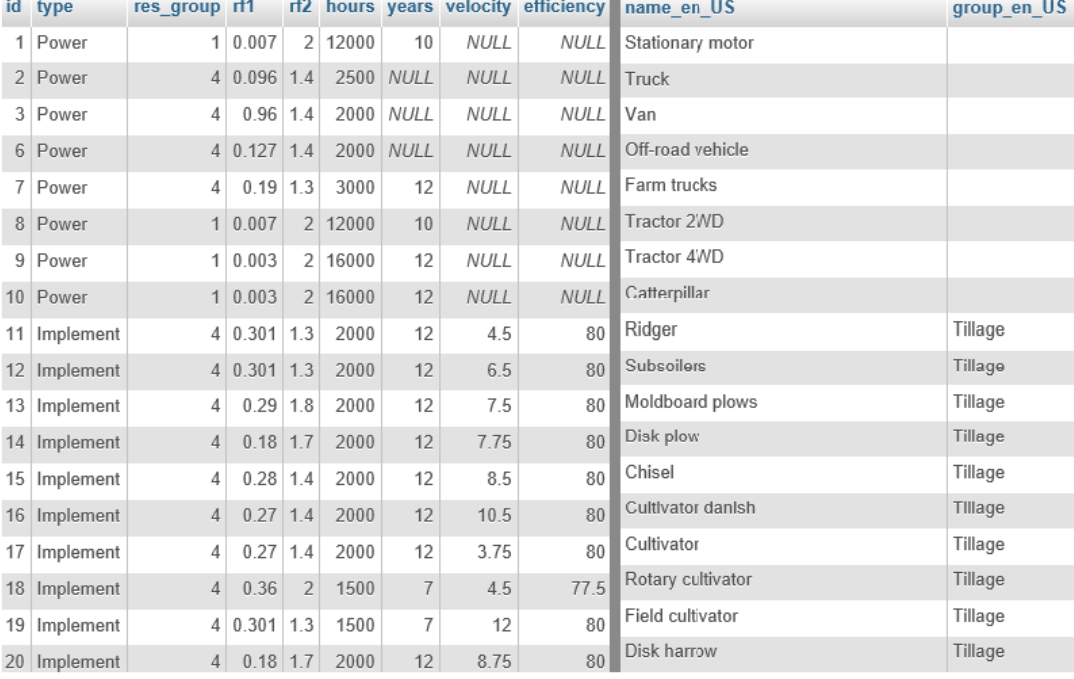
Figure 3: Screenshot of MACHoice’s data bases showing the parameters for machine cost estimates (left) and translation database (right). The explanation of these machine parameters will be presented on the section